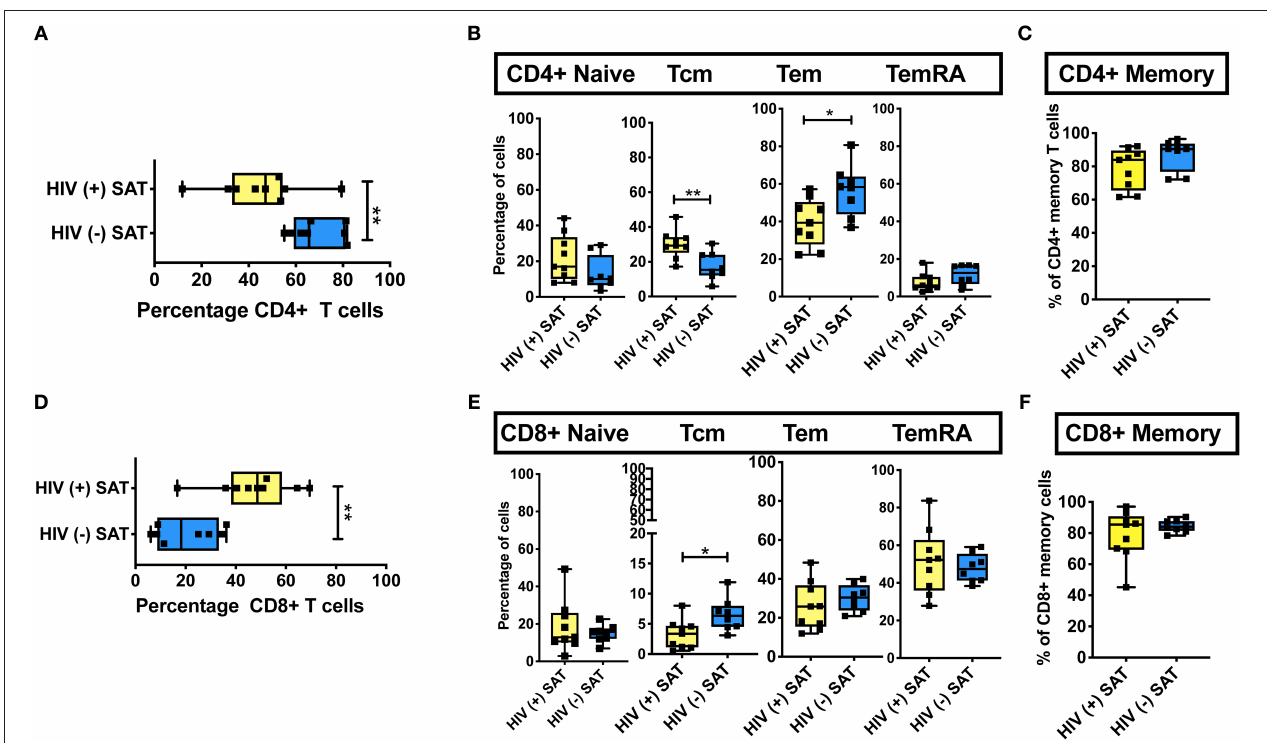
FIGURE 6 | Comparison of CD4 + and CD8 + T cell subsets in subcutaneous adipose tissue of PLWH and matched HIV-negative controls. Cells recovered from subcutaneous adipose tissue (SAT) of PLWH ( n = 9) and HIV-negative controls ( n = 8) with similar BMI and hemoglobin A1c were compared. (A) CD4 + T cells as a percentage of total live CD3 + T cells. (B) Frequencies of T Nai , T EM , T CM , and T EMRA cells in SAT of PLWH and HIV-negative controls. (C) Total CD4 + memory T cells (T CM + T EM + T EMRA ). (D) Similar analysis also done on CD8 + T cells, which are displayed as percentage of total live CD3 + T cells. (E) Frequencies of CD8 + T Nai ,